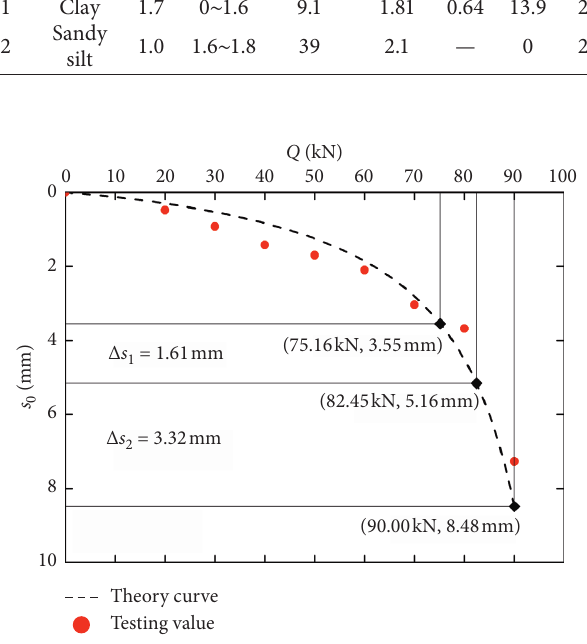
Figure 7: Comparison of Q-s curves in the field